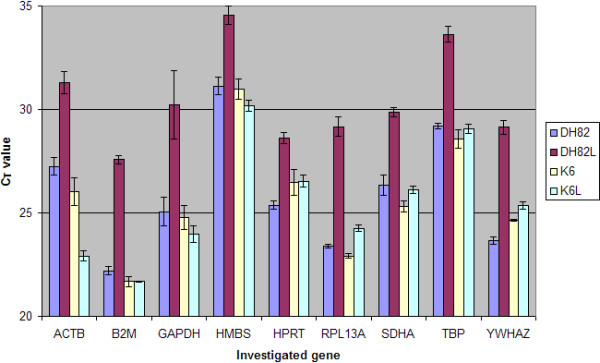
Mean expression values (± Standard Deviation [SD]) of canine cell lines (DH82, K6) before and after lipopolysaccharide stimulation (DH82L, K6L), following RT-PCR analysis.